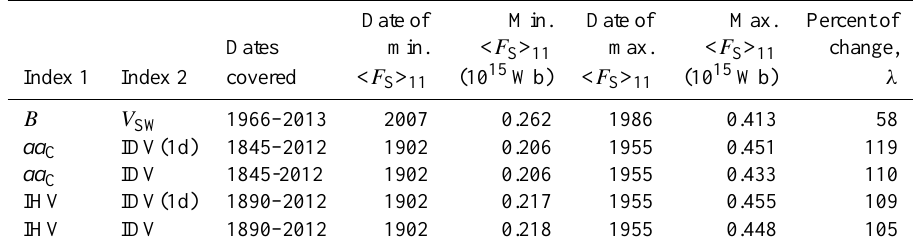
Table 3. Maximum and minimum of 11yr running means of annual signed open solar flux estimates < F S > 11 from the four combinations of geomagnetic activity indices and from in situ satellite observations (top row). The last column gives the percentage change, λ , between the minimum and the maximum. The first row is for in situ spacecraft measurements.